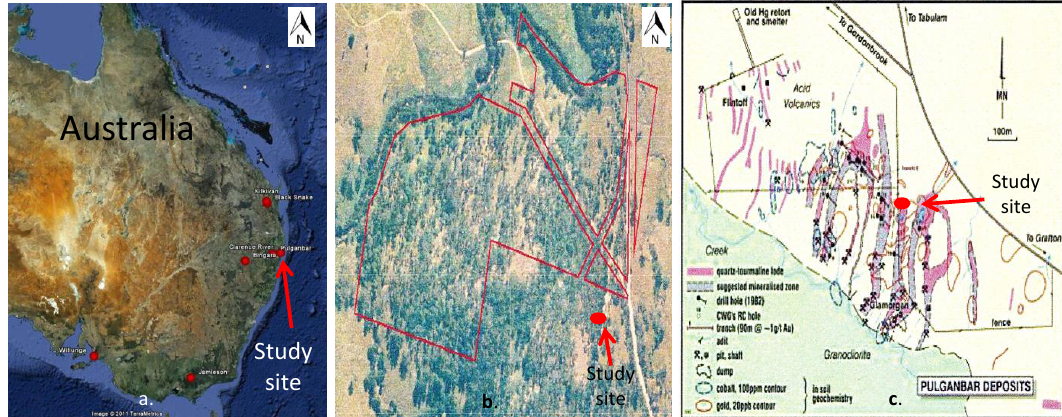
Fig. 1. Locations of pilot studies at Pulganbar, NSW. (a) Image from Google Earth maps 2010. (b) Aerial photograph of Pulganbar site (Central West Gold, 2008). (c) Pulganbar deposits (Central West Gold, 2008).